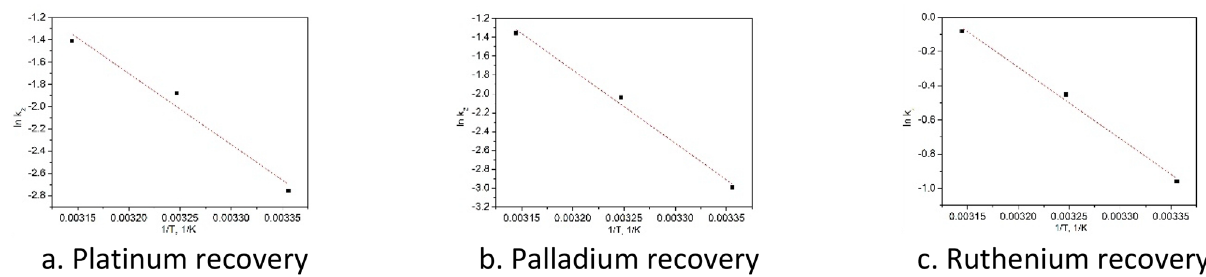
Figure 10. lnK 2 versus 1/T for adsorptions onto Ch-DB18C6.